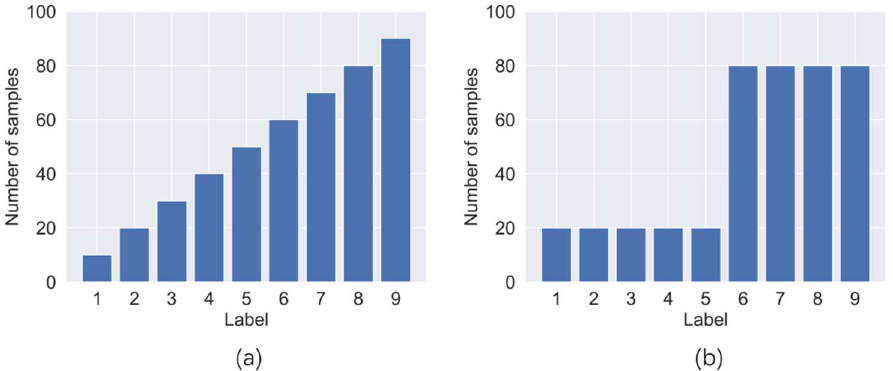
Figure 5. Two imbalance forms: ( a ) linear imbalance, ( b ) step imbalance.